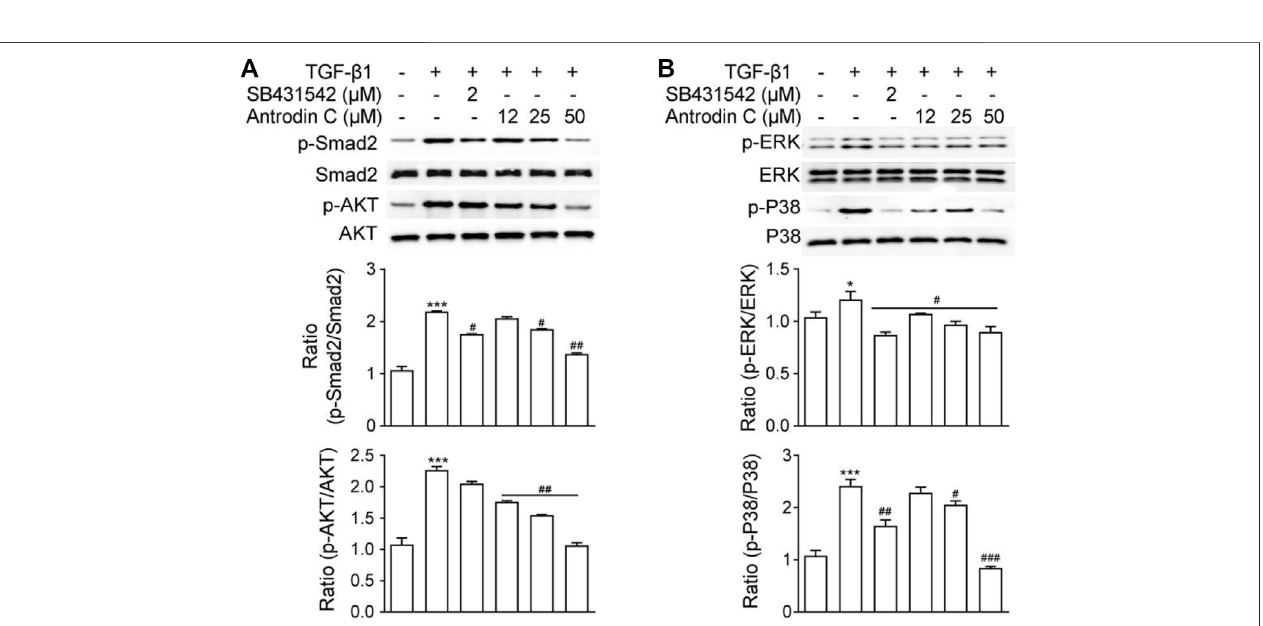
FIGURE 3 | Effects of Antrodin C on the TGF- β 1-induced signaling pathway. (A,B) CFSC-8B cells were treated with Antrodin C (12 – 50 μ M) for 2 h and then inducedbyTGF- β 1for 1 h, and totalcellular extracts wereprepared and subjectedtoWesternblotanalysistomeasure thelevels ofphosphorylatedSmad2, AKT, ERK, and P38. Total Smad, AKT, ERK, and P38 were used for normalization. Data represent mean ± SD ( n = 3), * p < 0.05, *** p < 0.001 compared with control; # p < 0.05, ## p < 0.01, ### p < 0.001 compared with TGF- β 1 treated only.